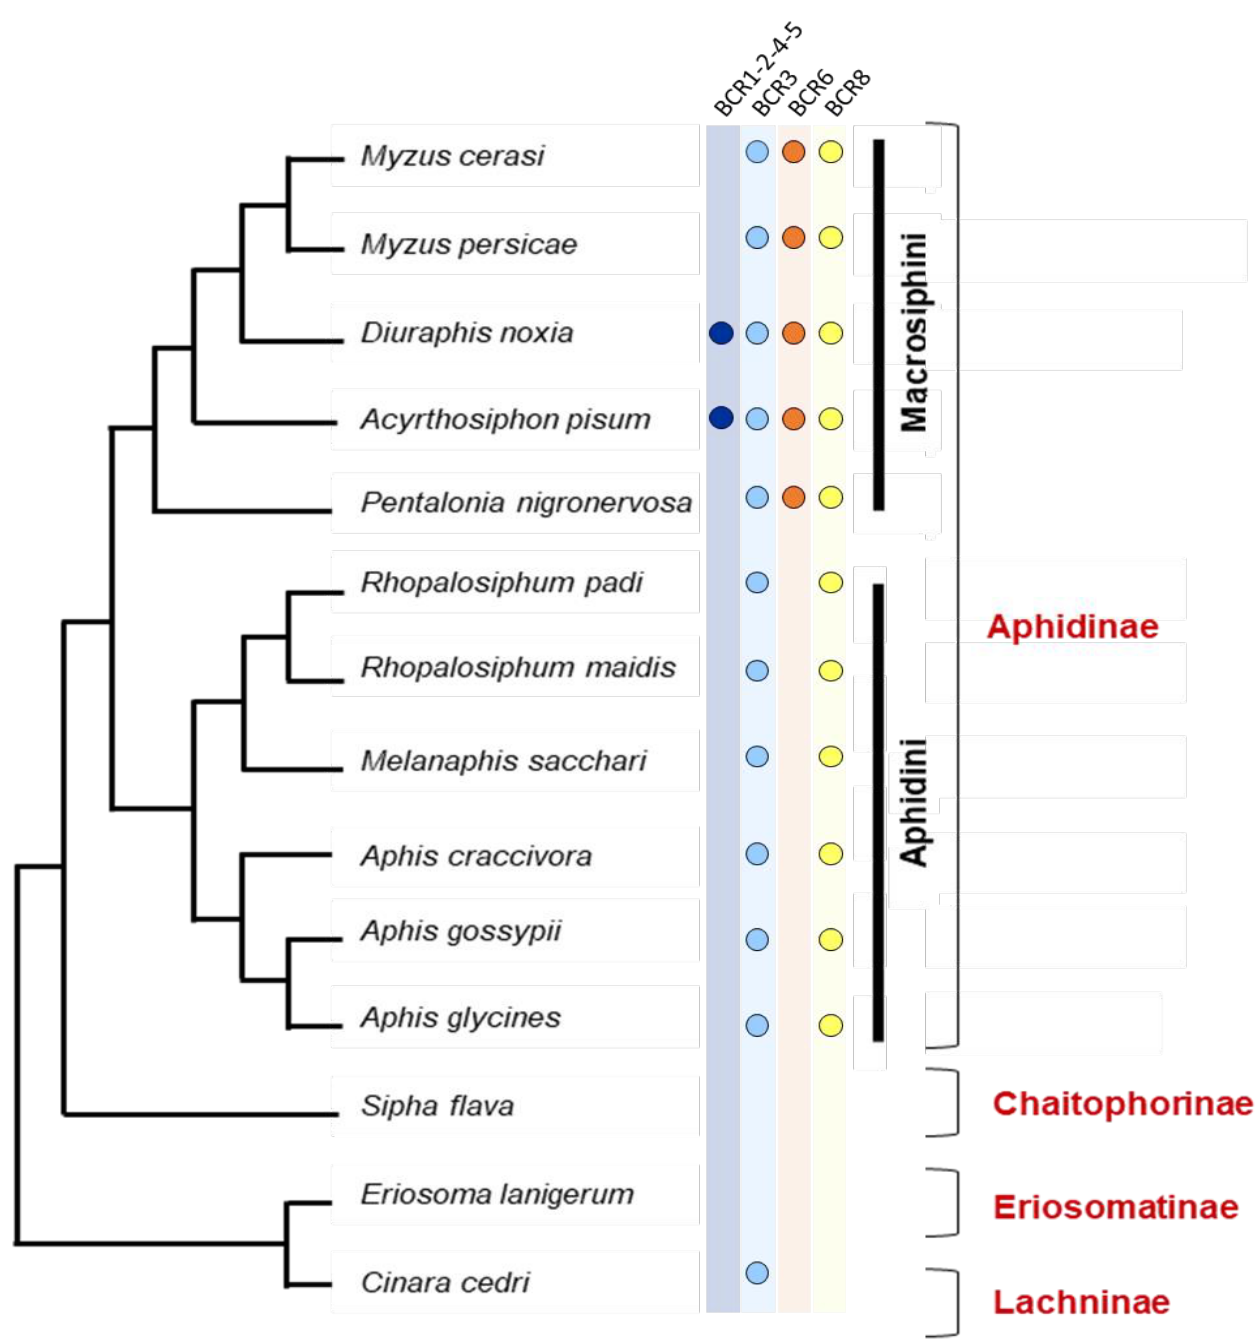
Figure 5. Partitioning of BCR peptides in aphid taxonomic groups. Phylogeny of the 14 members of the aphid group whose genome is annotated and available in databases (among the 19 with sequenced genomes). Their distributions into subfamilies and tribes are indicated in red and black, respectively (adapted from Calevro et al. [4]). Colored dots near each species name indicate whether a member of each BCR subfamily is present in the genome.